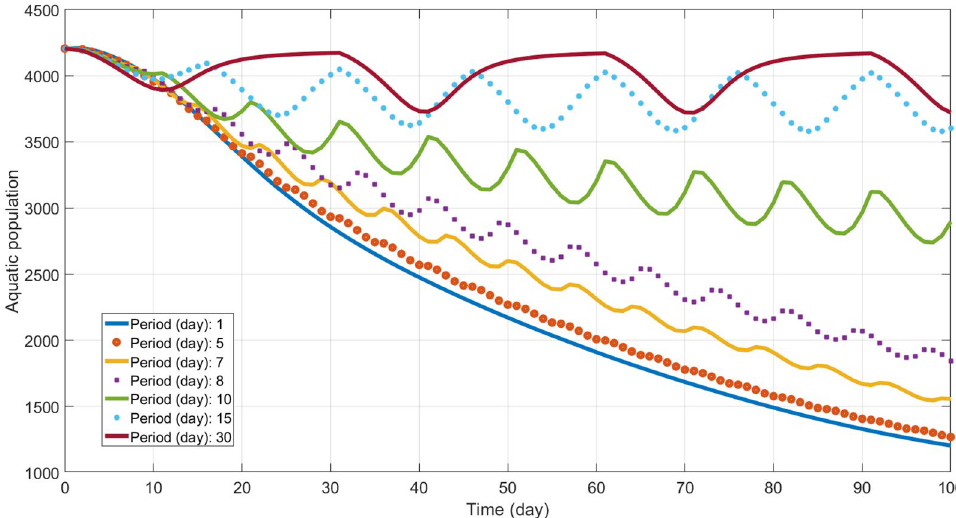
Figure 5. Temporal evolution of the aquatic phase population during 100 days with different release periods. The mosquitoes were liberated in a smaller central area highlighted on the left panel of Fig. 3.